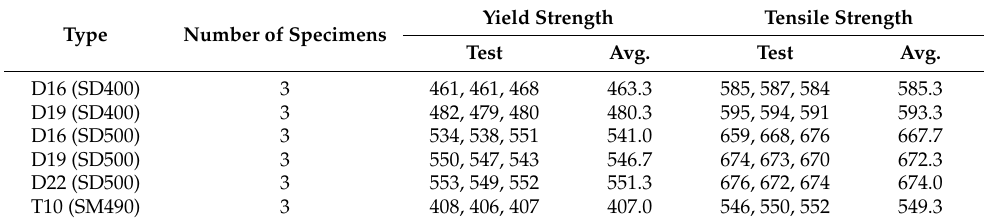
Table 3. Material properties for steel plate and reinforcements (unit: